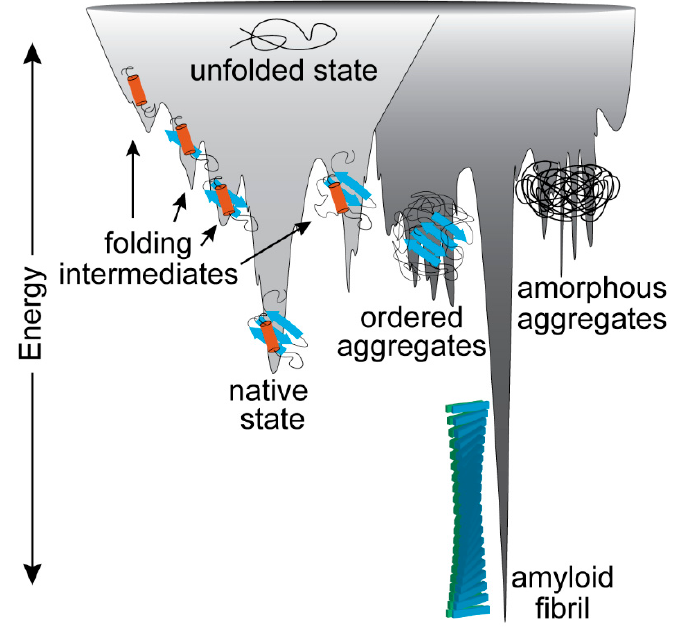
Figure 2. Cartoon showing the complex protein folding landscape. Nascent, unfolded proteins travel down an energy gradient seeking the lowest energy conformation. Proteins can sample various energy minima on this journey including folding intermediates and the native fold state. However, every protein has the potential to reach other energy minima, including unfolded or partially ordered aggregates. In addition, all proteins can adopt the true lowest energy state, the amyloid fibril. Adapted from Jahn and Radford [50].